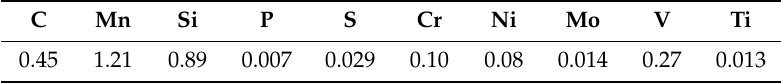
Table 6. Chemical composition in wt % of the 44MnSiVS6 micro-alloyed steel.